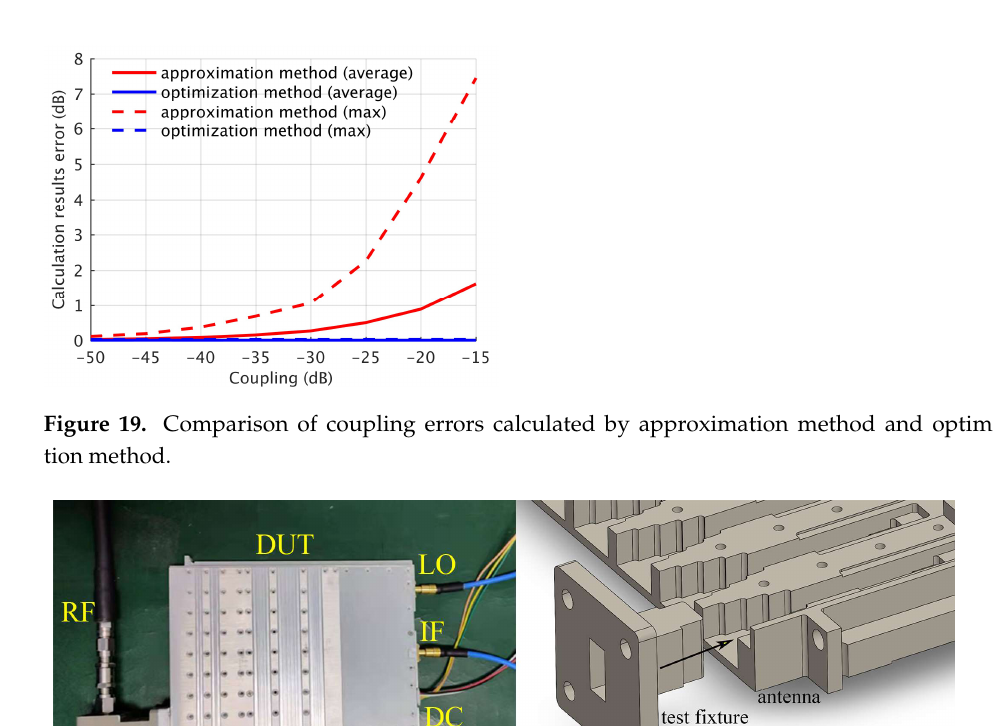
Figure 20. Diagrams of connection mode and test fixture.